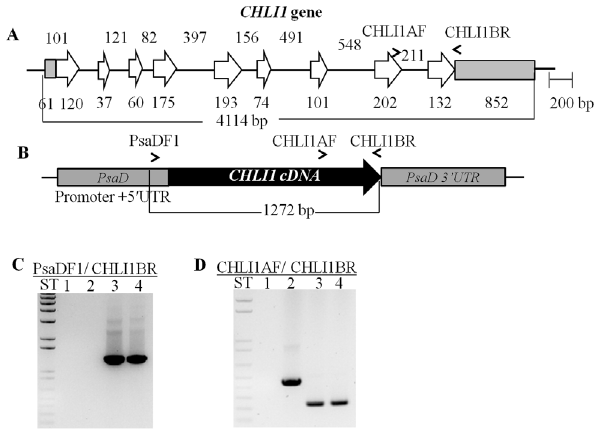
Figure 10. Molecular analysis of chli1-1 rescued transformants. ( A ) A schematic of the native CHLI1 gene. The tan bars denote UnTranslated Regions (UTRs), the white arrows represent exons and the black lines denote introns. ( B ) A schematic of the CHLI1- pDBle complementation vector containing the CHLI1 cDNA. PsaD promoter, 5´UTR, 3´UTR and CHLI1 specific primers are labeled. ( C ) Genomic DNA PCR using a PsaD 5´UTR specific primer and a CHLI1 specific primer. Product size: 1272 bp. Lane 1: chli1-1 ; Lane 2: 4A+; Lane 3: chli1-7 ; Lane 4: chli1-8 . ST represents 1 kb plus DNA ladder. ( D ) Genomic DNA PCR using CHLI1 specific primers. Genomic DNA product size: 459 bp; cDNA product size: 249 bp. Lanes 3 and 4 show smaller PCR products compared to that in lane 2 as cDNA was used